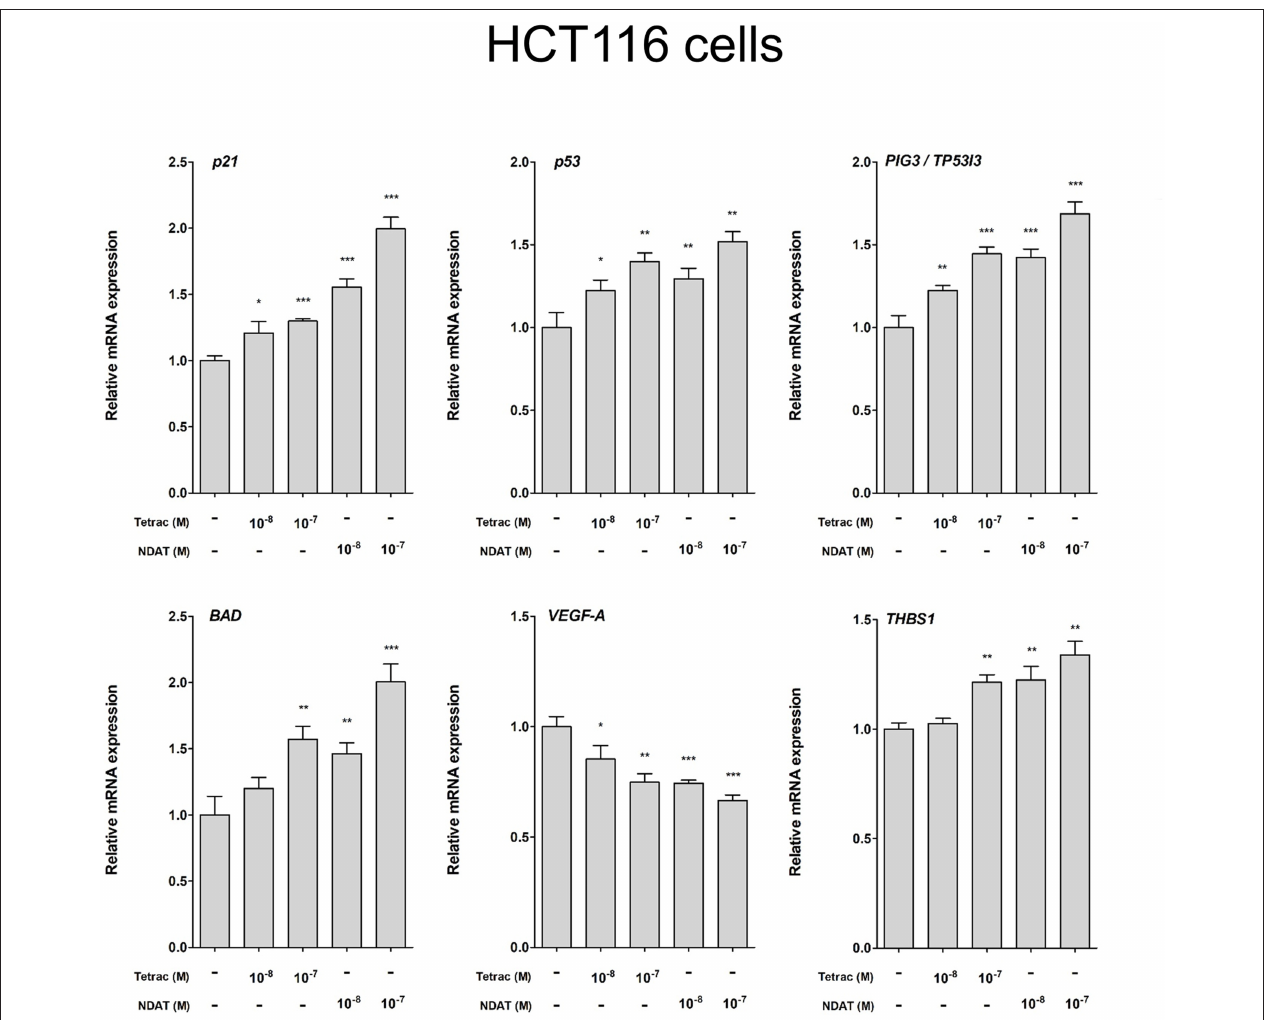
FIGURE 6 | Tetrac and NDAT suppress expression of proliferative and metastasis-related genes in HCT116 cancer cells. HCT116 cells were seeded in 6-well plates and treated with different concentrations of 10 − 8 and 10 − 7 M tetrac or NDAT for 24h. Cells were harvested and total RNA was extracted. Studies of qPCR were conducted to examine expression of anti-proliferative genes ( p21, p53, and PIG3 ), apoptotic gene ( BAD ), and metastasis-related genes ( VEGF-A and THBS1 ). N = 6. (Data are expressed as mean ± SD; * p < 0.05, ** p < 0.01, *** p < 0.001, compared with untreated